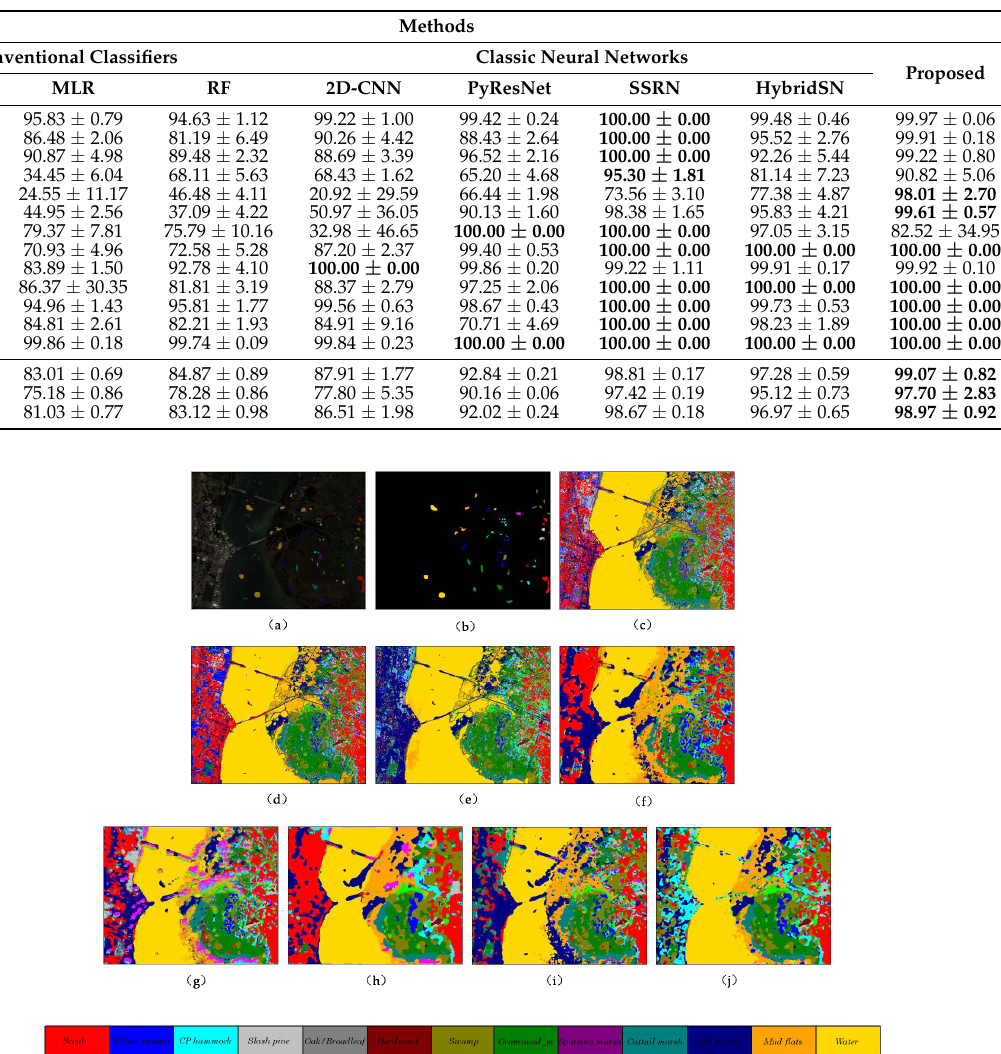
Figure 9. The classification maps of different methods on Kennedy Space Center dataset. ( a ) false color map with truth labels, ( b ) ground truth, ( c ) RBF-SVM, ( d ) MLR, ( e ) RF, ( f ) 2D-CNN, ( g ) PyResNet, ( h ) SSRN, ( i ) HybridSN, and ( j ) proposed. The selection of samples for training, validation, and testing on Salinas Valley and Grass_dfc_2013 datasets is consistent with the list of samples in Tables 3 and 4. Mean-